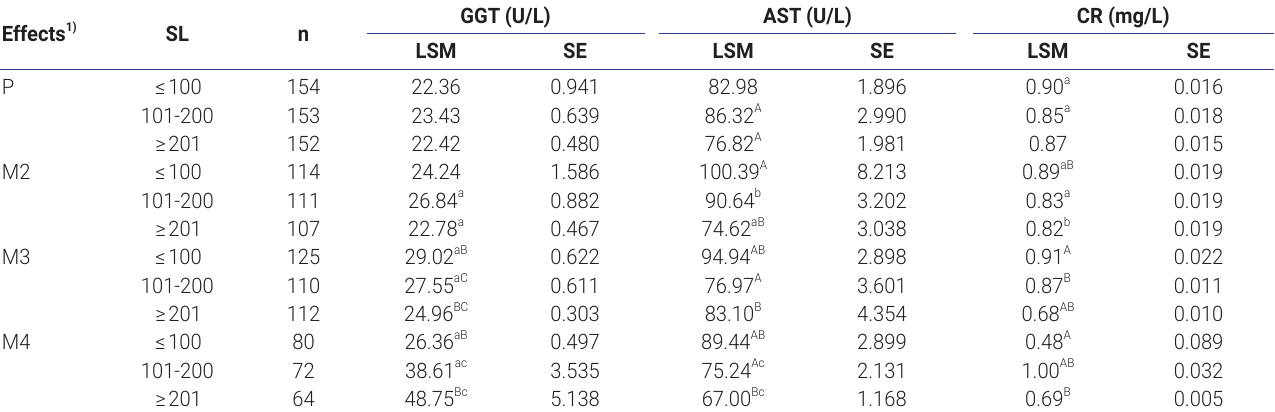
Table 5. The effect of parity number and lactation stage on the level of gamma-glutamyl transferase, aspartate aminotransferase, and creatynine in cow blood serum Effects